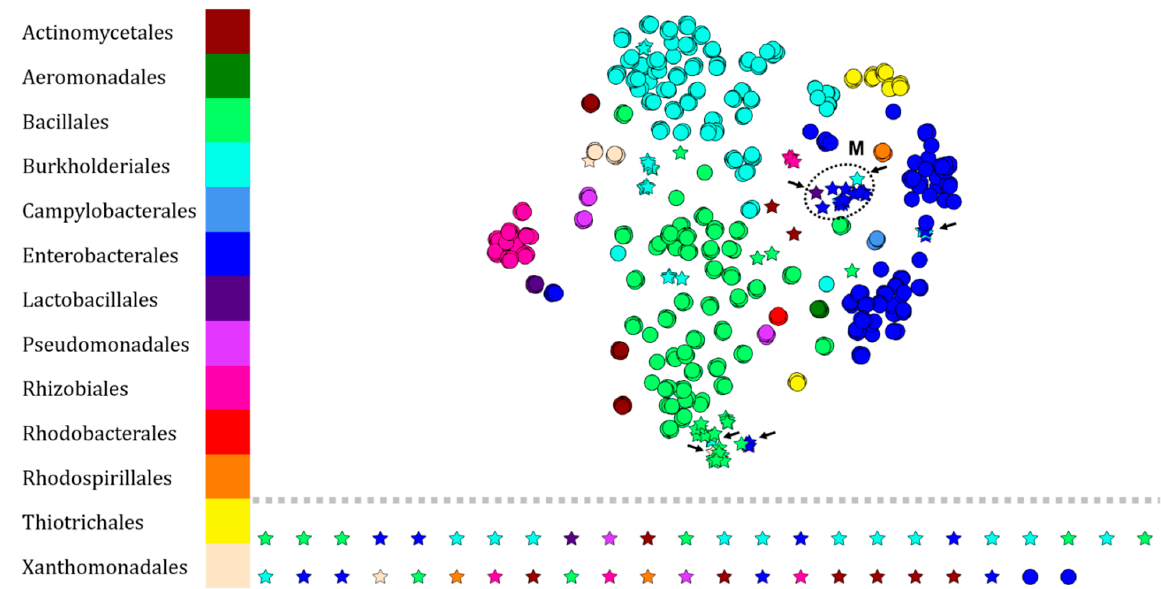
Figure 3. Visualization of 706 protein fingerprints of pathogenic bacteria (166 strains—RKI’s database; • ) and environmental bacteria (138 isolates—BNSB’s database; ★ ) set by t-SNE. Each node represents the protein fingerprint of an isolate and is colored according to the taxonomic order of the organism. Arrows indicate illogical attributions within clusters. The annotated cluster M consists mainly of enterobacteria.